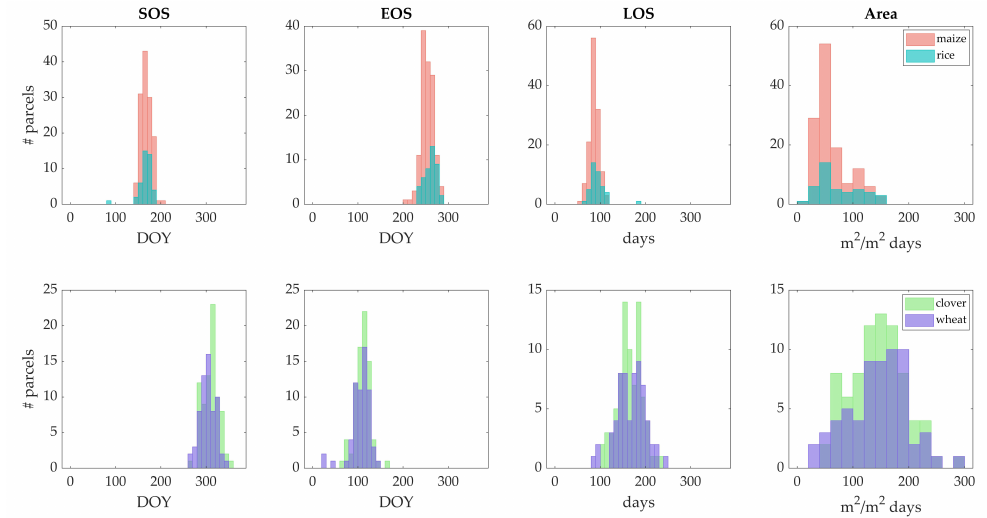
Figure 5. Histogram of SOS, EOS, LOS and Area metrics calculated from SL30 GPR 2016–2019 time series over all available parcels of maize, rice, clover and wheat crop types. Data are grouped in 15-day